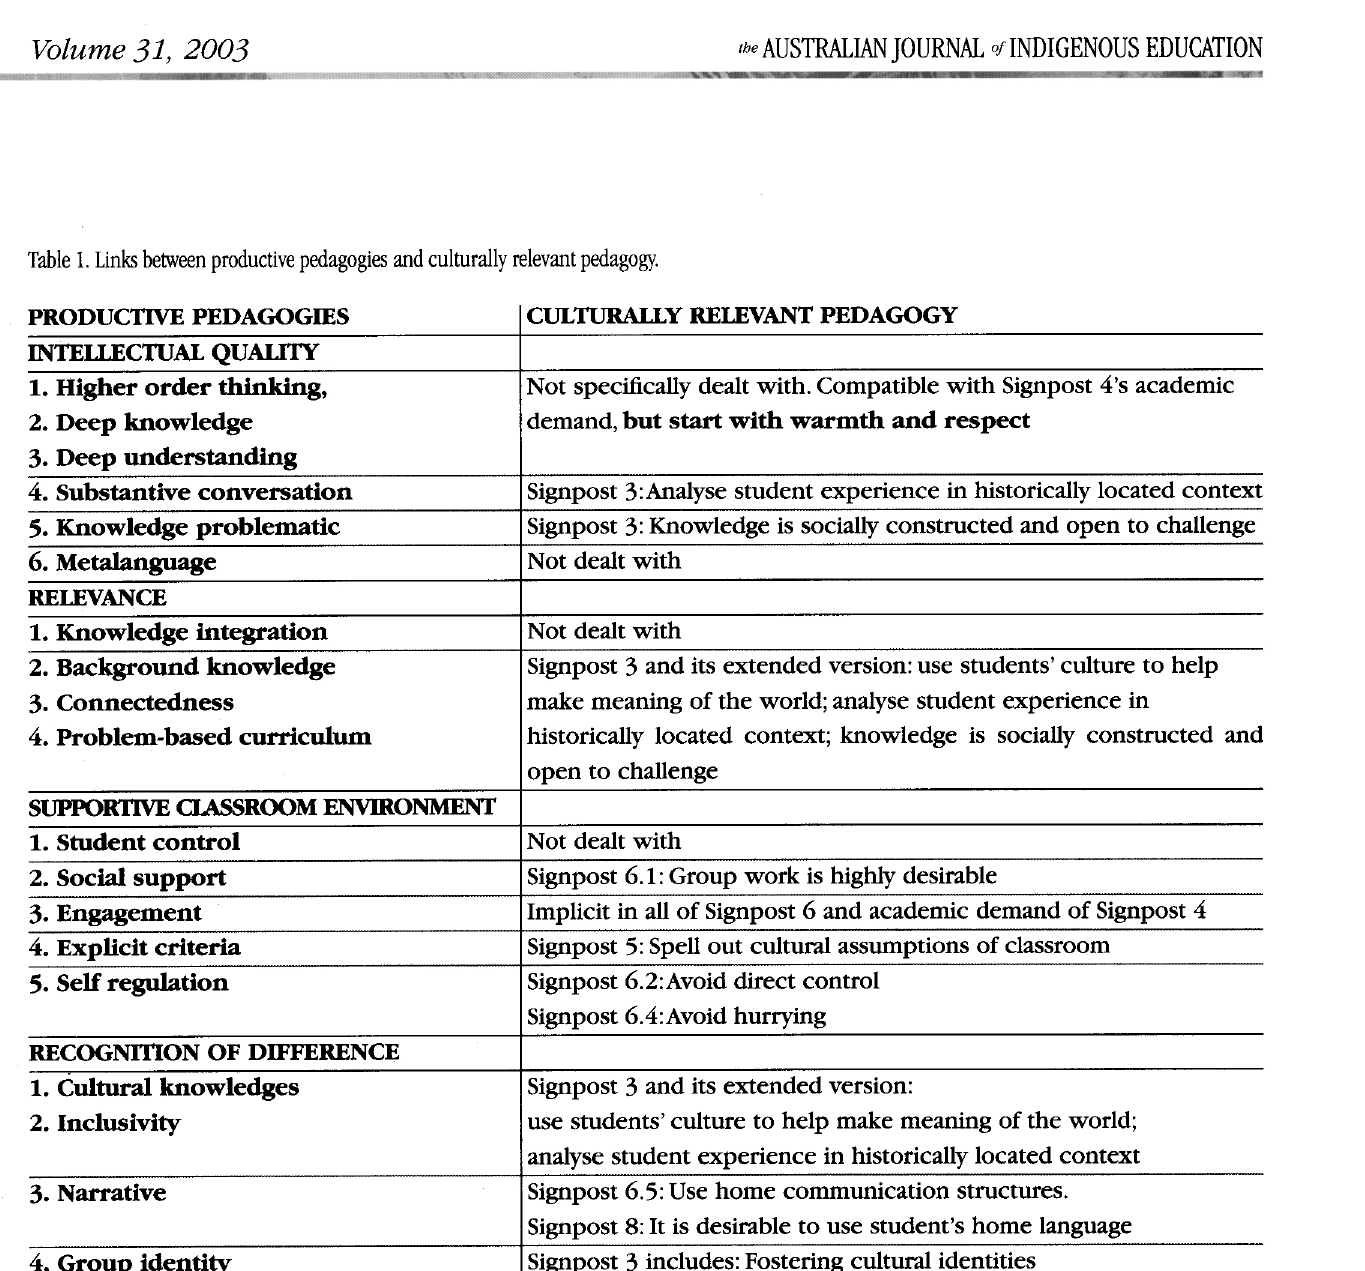
Table 1. Links between productive pedagogies and culturally relevant pedagogy. PRODUCTIVE